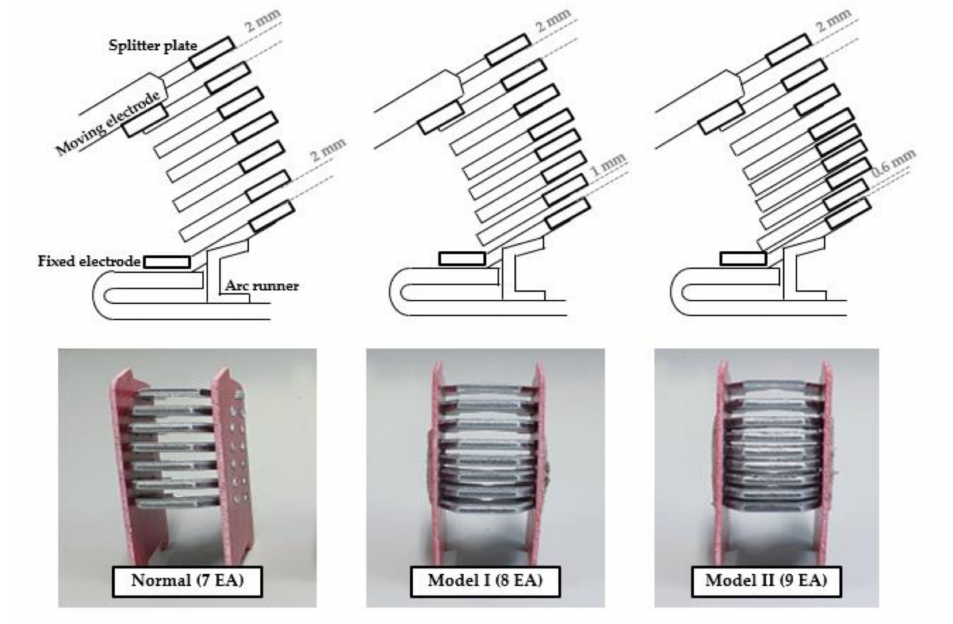
Figure 7. Lower plates interval change models.